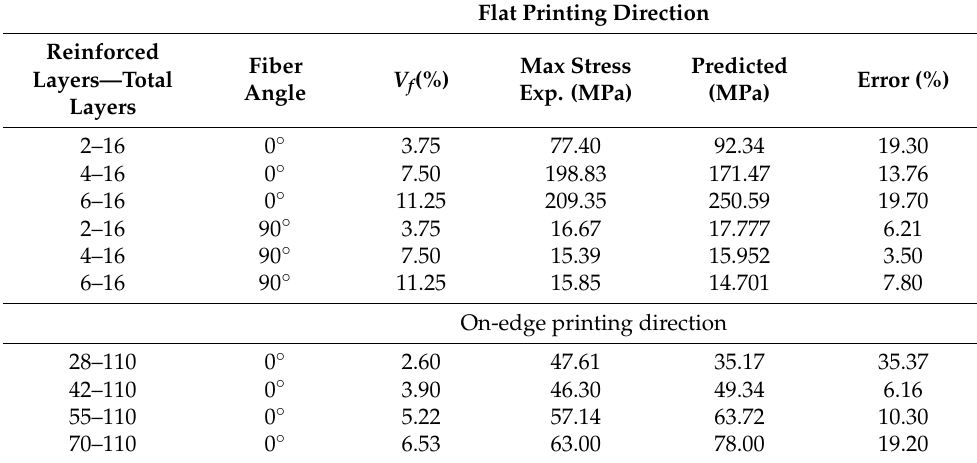
Table 5. Processed data for strength comparison for FRAM.